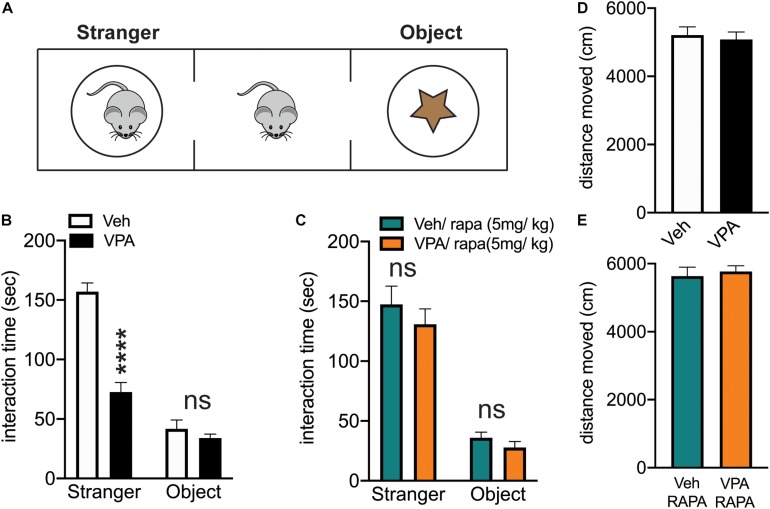
In utero exposure to VPA reduces social approach behavior which is rescued by mTOR inhibition. (A) Schematic of three chamber arena. Subjects are placed in the center chamber and allowed to explore for 10 min. After this, a conspecific mouse (stranger) is placed in one side chamber and an object is placed in the other side chamber. The subject is allowed to explore the entire arena for 10 min and time spent interacting with either the conspecific (stranger) or the object is recorded. (B) The interaction time with stranger and object for control (Veh) and VPA-exposed mice (VPA). Two-way repeated measures ANOVA: treatment x chamber F(1,12) = 30.48, ****p < 0.0001. (C) Rapamycin treated Veh and VPA exposed mice show no difference in interaction time with the stranger. Two-way repeated measures ANOVA: treatment x chamber F(1,12) = 0.1397, p = 0.7151. Treatment: F(1,12) = 1.584, p = 0.2321. Chamber: F(1,12) = 89.93, p < 0.0001. (D,E) No difference in locomotor activity between Veh and VPA-exposed mice at baseline or following rapamycin treatment. (D) unpaired, two-tailed t-test, t12 = 0.3940, p = 0.7005. (E) Unpaired, two-tailed t-test, t12 = 0.4253, p = 0.6781.